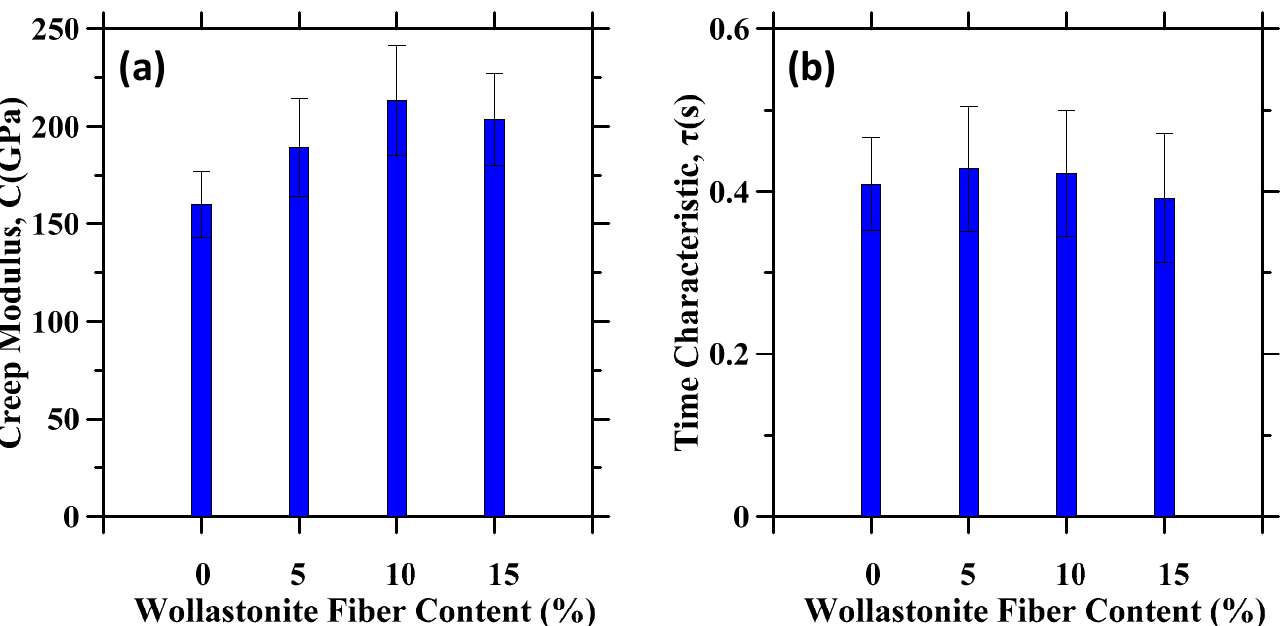
Figure 5. ( a ) The creep modulus and ( b ) time characteristic of the control and wollastonite-fiber- reinforced samples.